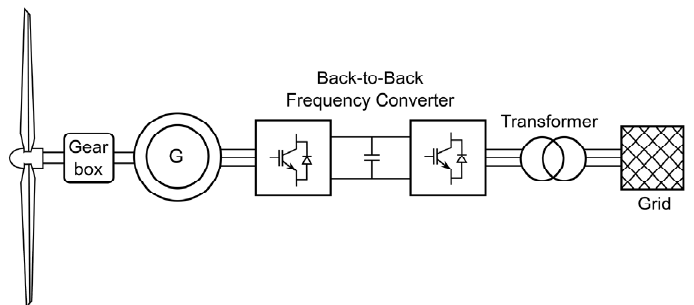
Figure 3. Diagram of a full converter wind turbine.